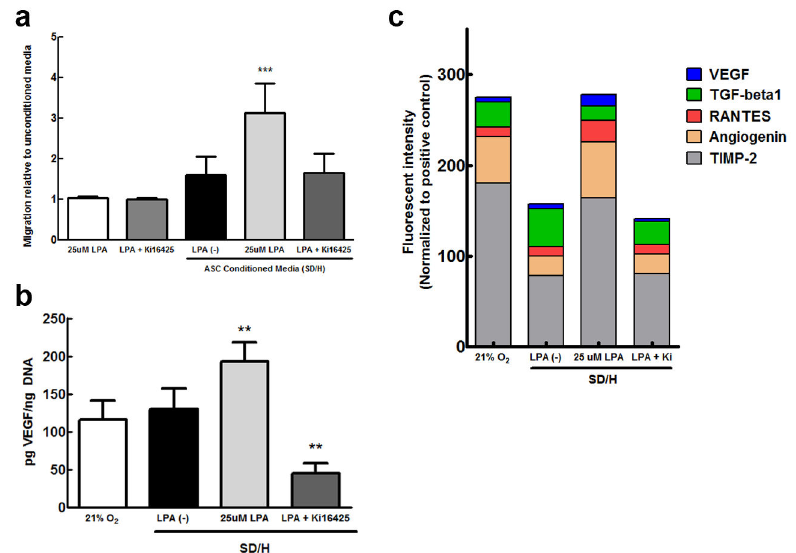
Figure 3. ASC treated with LPA promote endothelial cell migration. ( a ) Medium conditioned by ASC in the presence of LPA under SD/H is significantly more chemoattractive to ECFC than medium from non-treated or inhibitor-treated ASC. The addition of LPA or Ki16425 to unconditioned medium had no effect on ECFC migration ( n = 5). ( b ) LPA promotes VEGF secretion from ASC entrapped in 3D fibrin gels under SD/H compared to cells treated with no LPA or Ki16425. ( n = 6). * p < 0.05 vs. control, ** p < 0.01 vs. control, *** p < 0.001 vs. control ( c ) LPA also increases production of other angiogenic and inflammatory cytokines. Data are presented as average subtracted background fluorescence intensity normalized to positive